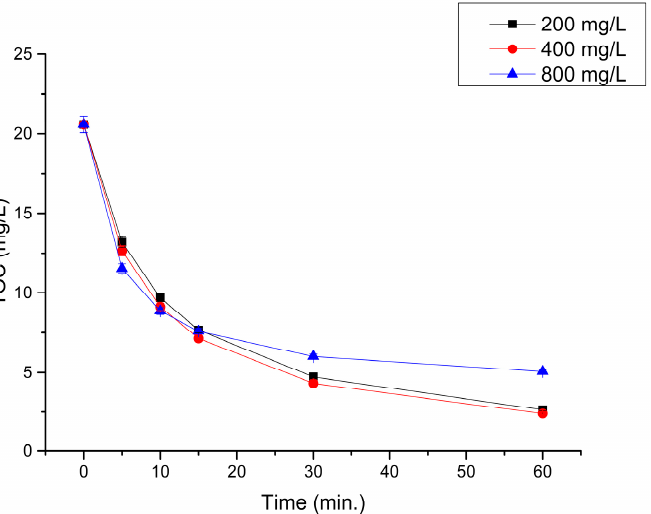
Figure 3. AM E 123 decomposition through the UV/ZVI/H 2 O 2 process, for selected H 2 O 2 doses and 500 mg L − 1 ZVI, pH = 3.0.